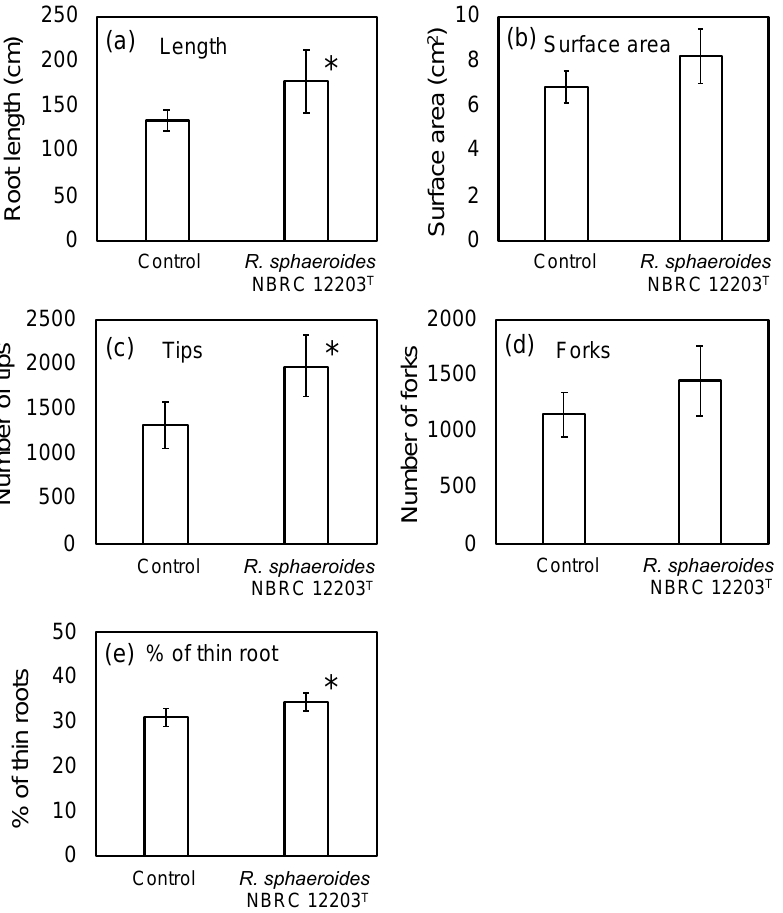
Figure 3. Effect of bio-priming by R. sphaeroides NBRC 12203 T (live cell) on ( a ) root length, ( b ) surface area, ( c ) number of tips, ( d ) number of forks, and ( e ) % of thin (0.1 mm < diameter) roots. The rice seeds were bio-primed by PNSB for 24 h, sown onto a cell pot and cultivated for 14 days. Data are means ± SD ( n = 5). An asterisk indicates the result that was significantly different (* p < 0.05) from the control.